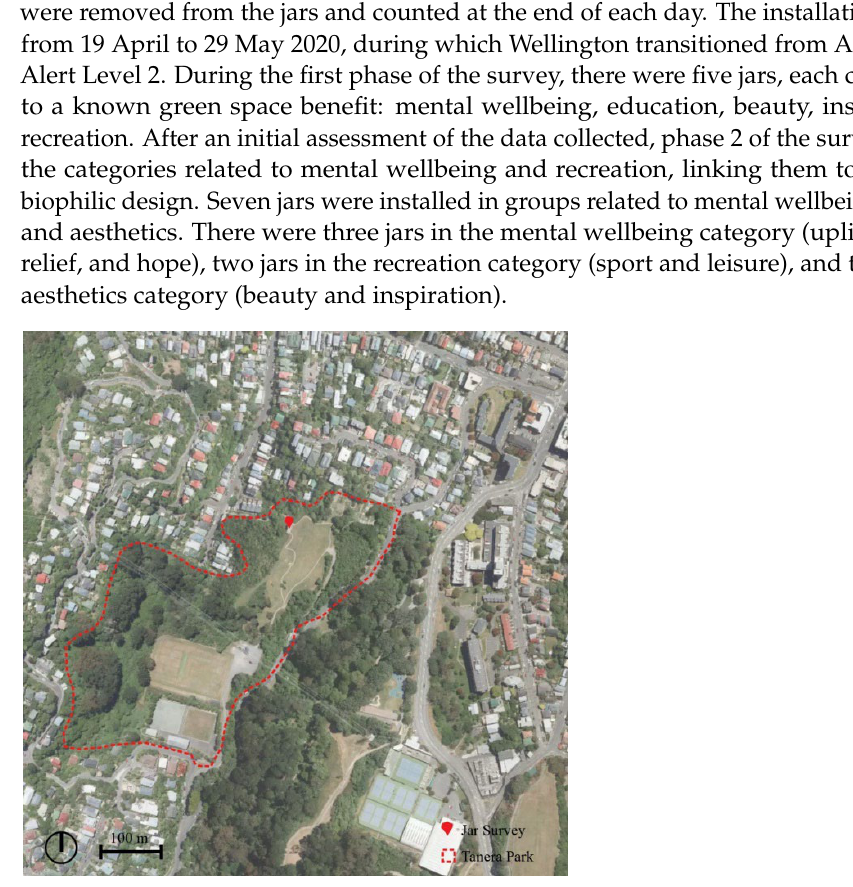
Figure 3. The location of the jar survey in Tanera Park in Aro Valley, Wellington. The base satellite image is from Landcare Research [37].